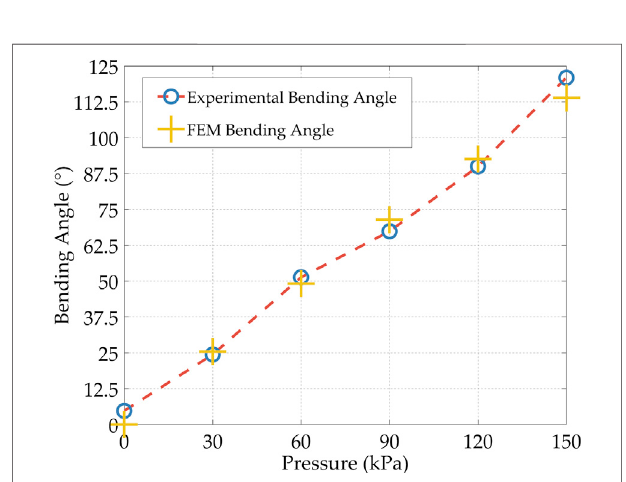
FIGURE 4 | Experimental and FEM bending angle for the soft monolithic fi nger under different applied positive pressures.